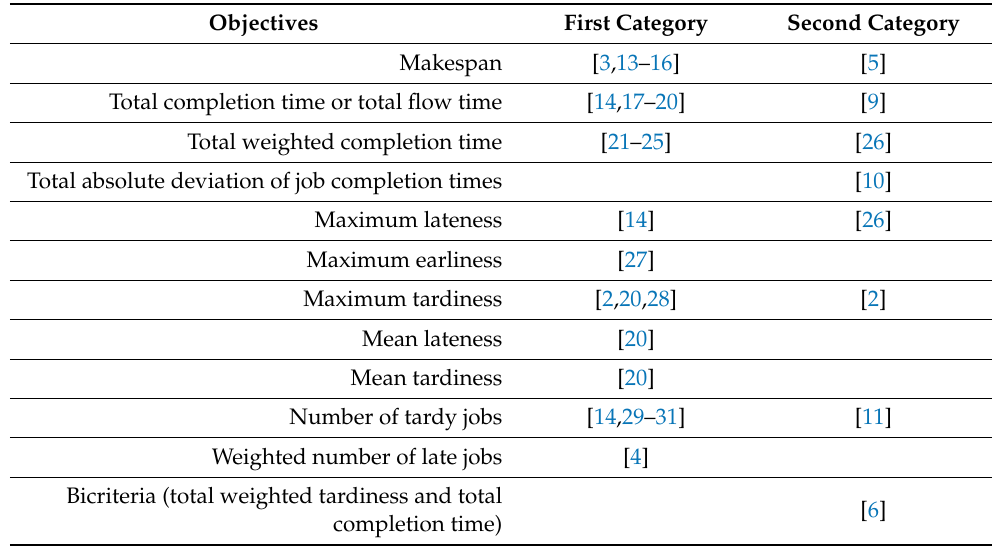
Table 1. Two categories of related studies for the considered